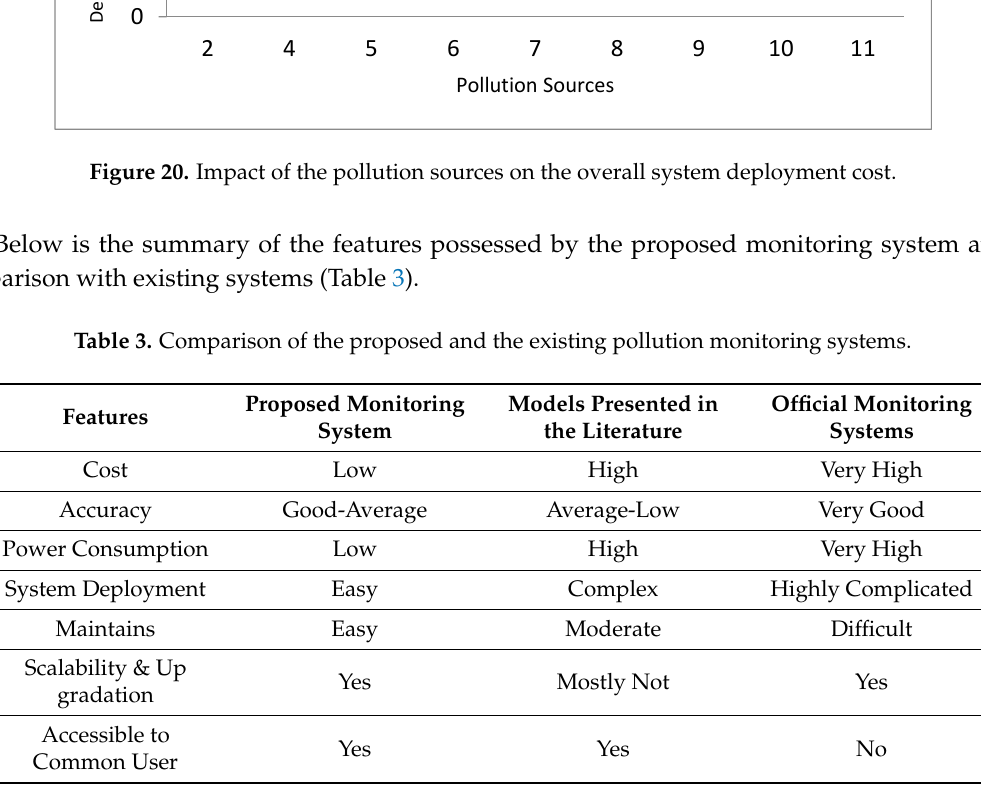
Figure 21. Impact of the pollution sources on the overall system deployment cost.